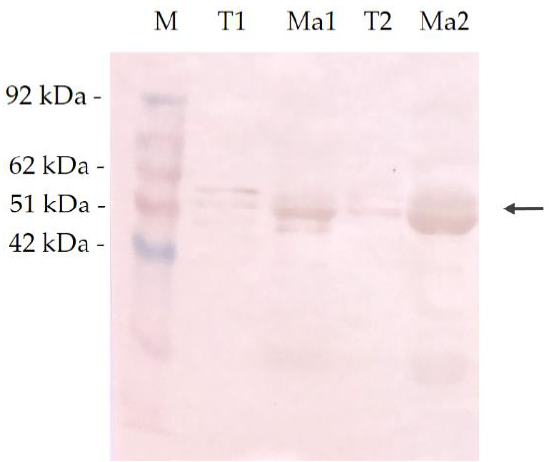
Figure 5 . Positive cross - reactivity of MAb 6C1, testis, mammary gland tumors and canines . Western Figure 5. Positive cross-reactivity of MAb 6C1, testis, mammary gland tumors and canines. Western blot analysis of testicular and CMT cells with human anti-MAGE Mab 6C1. Black arrows indicate the blot analysis of testicular and CMT cells with human anti - MAGE Mab 6C1 . Black arrows indicate the positive cross-reactivity at approximately 42–62 kDa; M—protein marker (kDa); T1; T2—protein of testicular samples; Ma1; Ma2—protein of IHC positive malignant CMT